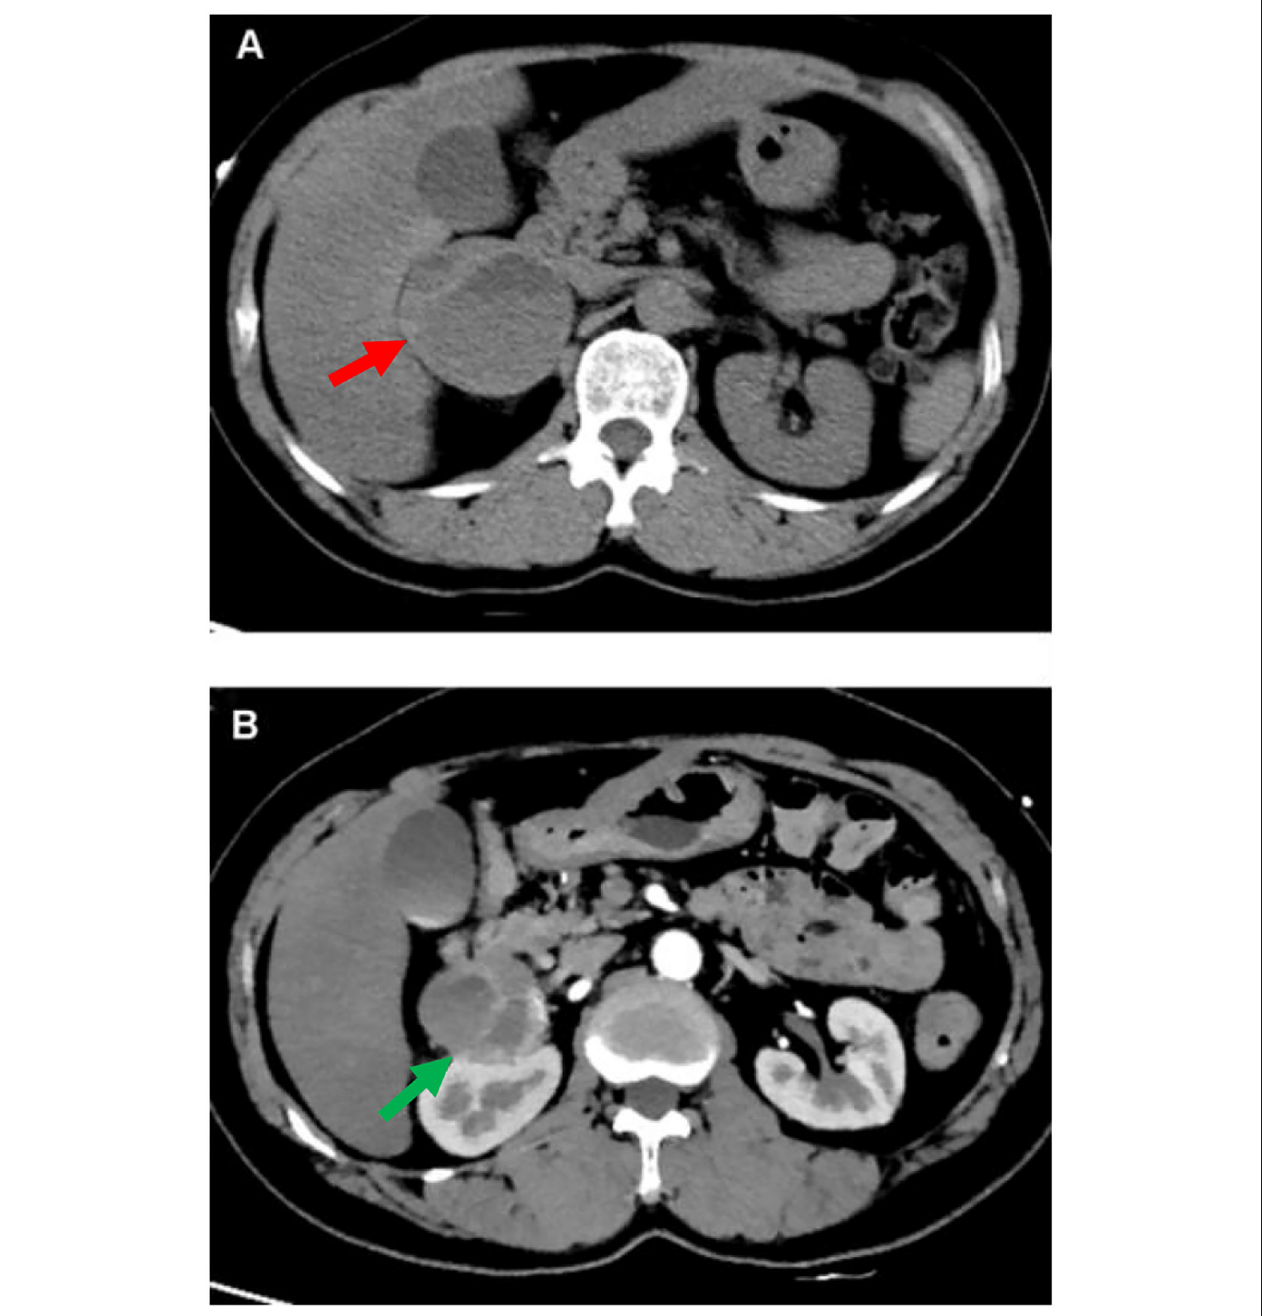
FIGURE 2 | CT of abdomen. A computed tomographic (CT) of the upper abdomen (axial view) shows a 53 mm*58mm heterogeneous tumor of the right adrenal gland [ (A) red arrow]. Axial contrast-enhanced CT image shows the mass compose of solid enhancing component and cystic component [ (B) green arrow].